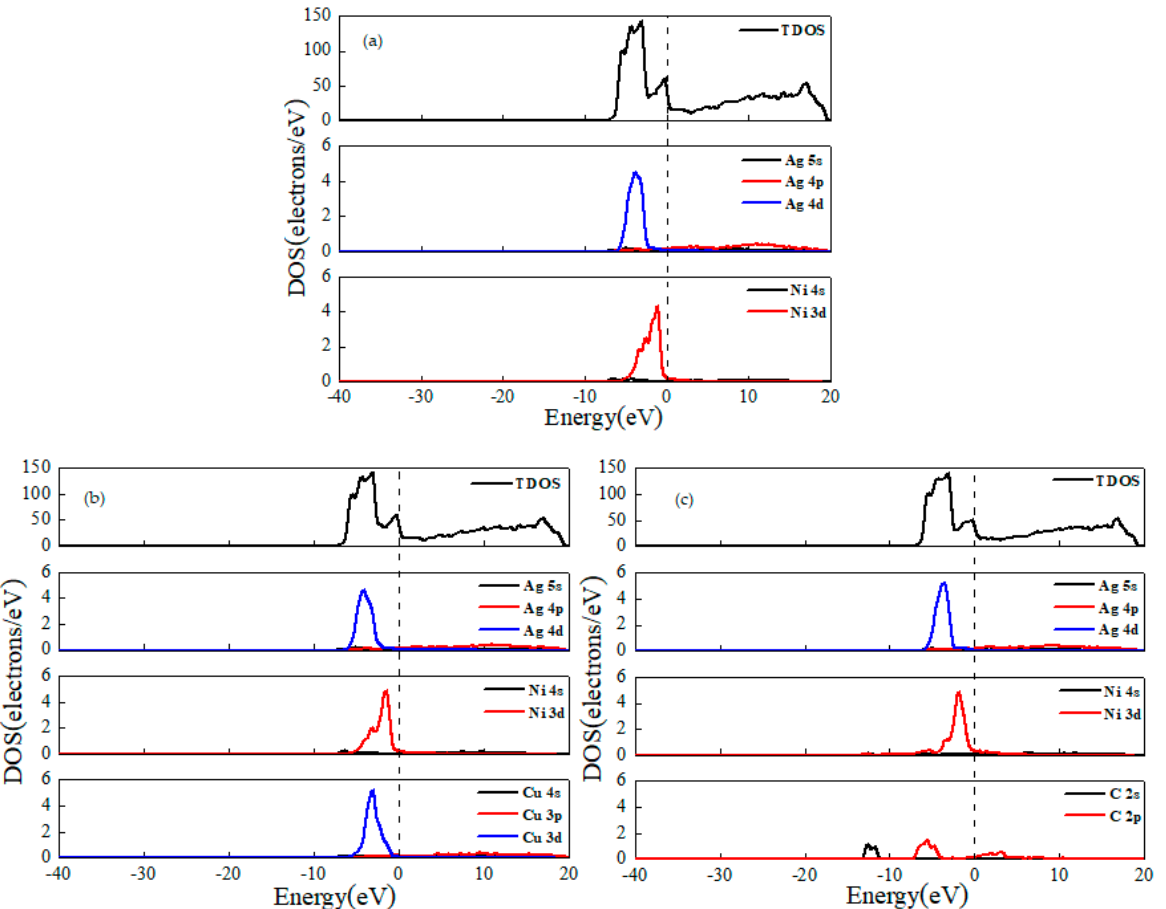
Figure 2. Density of states: ( a ) Ag/Ni, ( b ) Ag/Ni-Cu, and ( c ) Ag/Ni-C.